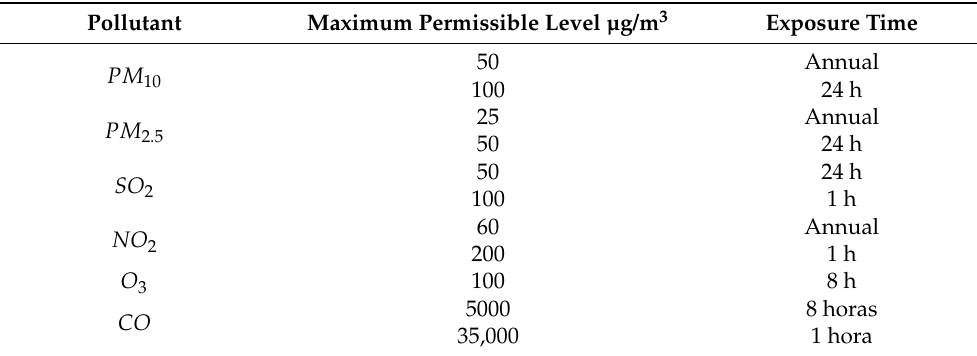
Table 4. Maximum permissible levels of criteria pollutants in the air. Resolution 2254 of 2017, from the Ministry of Environment and Sustainable Development of Colombia [50].